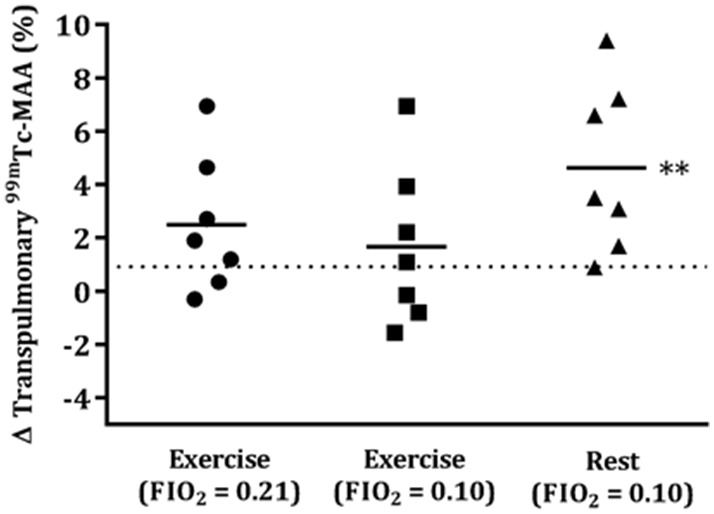
Change in the transpulmonary passage (%) of 99mTc-MAA compared to resting, normoxic gas breathing.Dashed line indicates the repeatability coefficient (0.92%) Transpulmonary 99mTc-MAA passage was noted in 6/7 participants performing exercise in normoxia and 4/7 participants performing exercise in hypoxia. Breathing hypoxic gas at rest increased 99mTc-MAA passage in all participants relative to hypoxic exercise. ** indicates a difference compared to hypoxic rest (p = 0.001).